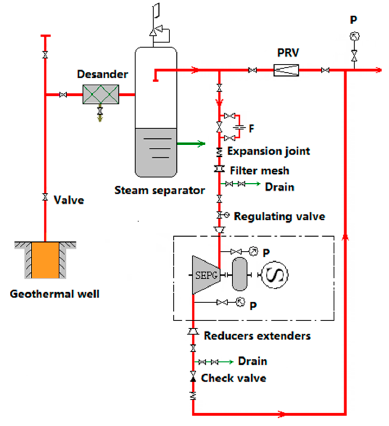
Figure 2. Schematic drawing of the screw expander power generation unit.